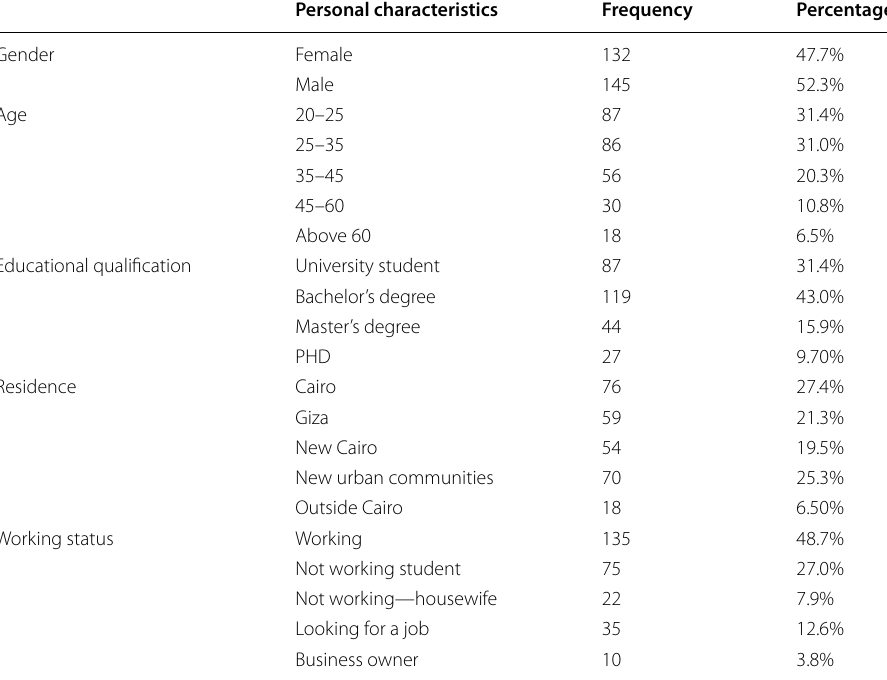
Table 1 Personal and residential characteristics of the survey respondents Personal